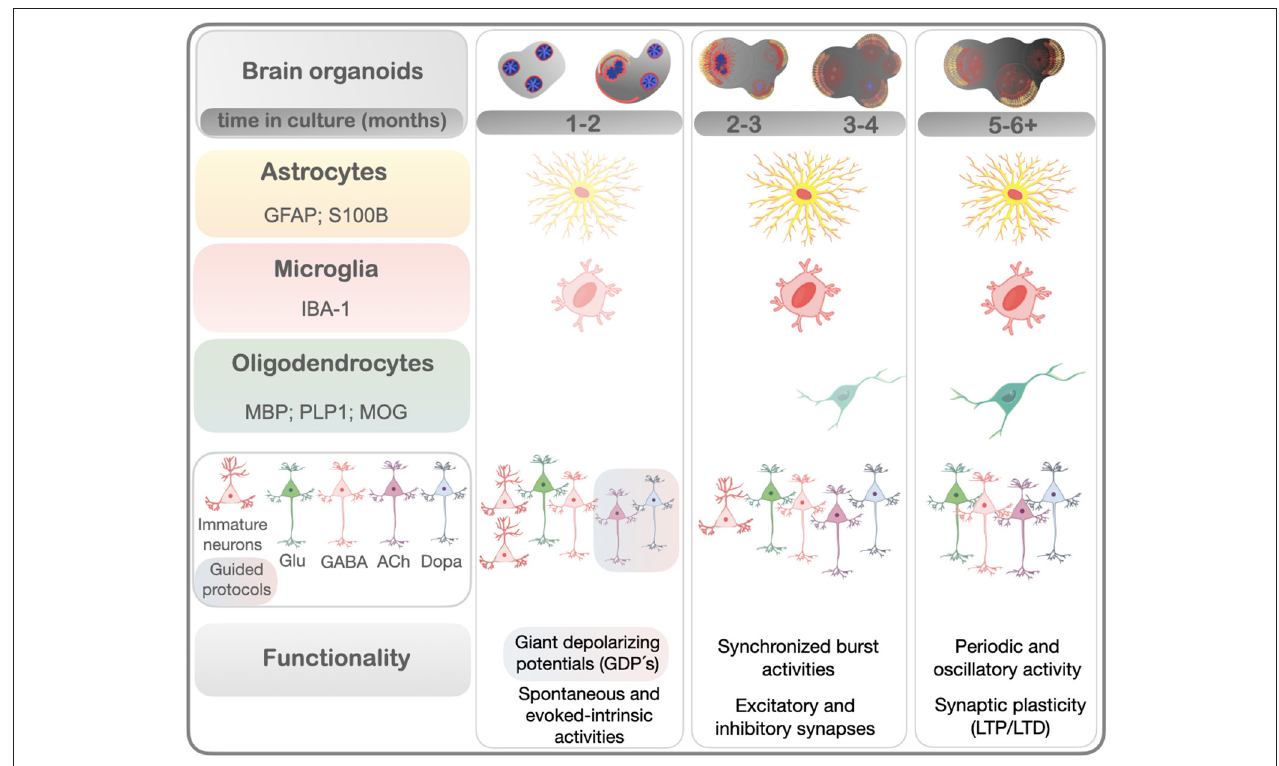
FIGURE 1 | Cell types/markers and functional properties reported in brain organoids in a time-dependent fashion, according to the literature. This timeline summarizes the emergence of the main mature cell types in brain organoids from distinct protocols, shown in months. Neurons start to appear in earlier times of culturing ( ∼ 1 month). Dopaminergic and cholinergic neurons were found enriched in guided protocols. Markers of astrocytes and microglia increase from 1 month, while oligodendrocytes gradually emerge from 3 months of culturing. Early functional properties of developing brains such as giant depolarizing potentials (GDPs)-like can be recorded around 1 month of culture in guided protocols. Electrophysiological maturation such as synchronized burst firing activities, both action and spontaneous inhibitory/excitatory postsynaptic potentials, gradually emerge over time (from 2 months). More complex neural networks resulting from